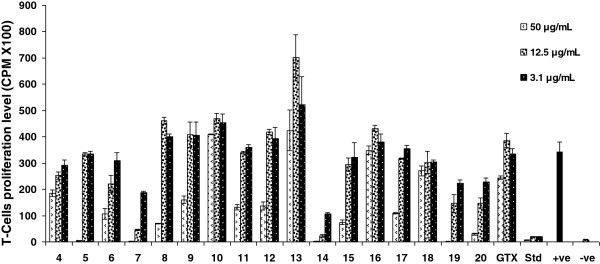
The modulatory effects of gatifloxacin (GTX) and its analog compounds (4–20) on mitogen activated T-cell proliferation compared with prednisolone (Std). Each bar represents a mean triplicate reading. +ve = Cells with PHA, -ve = Cells without PHA.